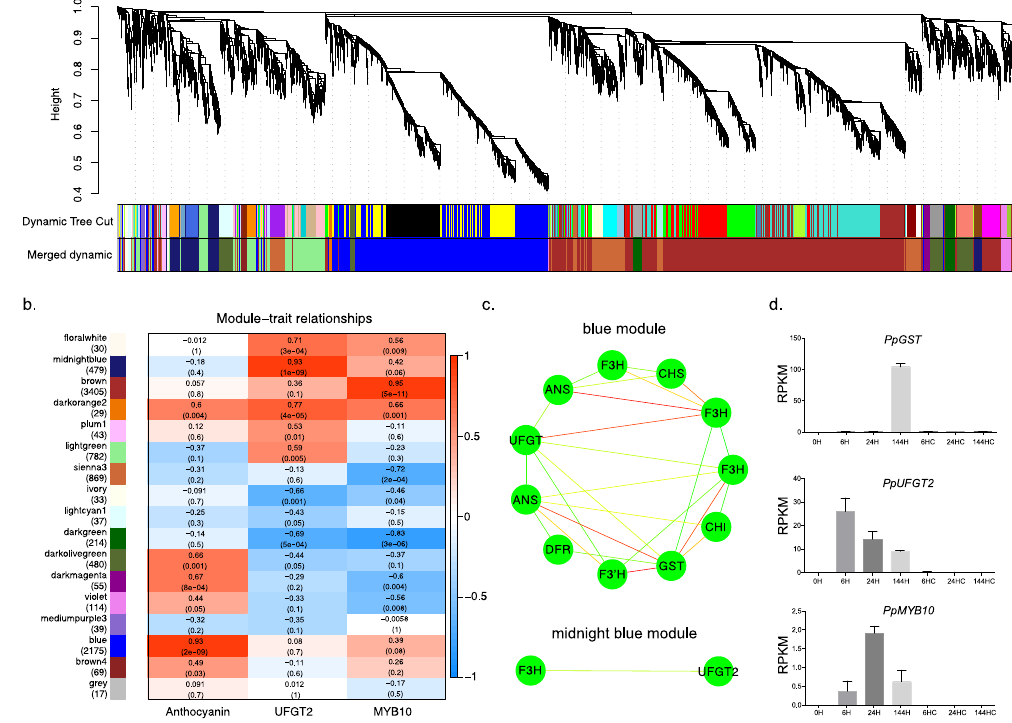
Figure 3. Weighted gene co-expression network analysis (WGCNA) of DEGs identified from ‘Meirensu’ pear peel after bag removal. ( a ) Hierarchical cluster tree showing 17 modules of co-expressed genes. Each of the 8,870 DEGs is represented by a tree leaf and each of the modules by a major tree branch. The lower panel shows modules in designated colours. ( b ) Module–trait correlations and corresponding p -values (in parentheses). The left panel shows the 17 modules and the number of member genes. The colour scale on the right shows module– trait correlations from − 1 (blue) to 1 (red). The left panel “Anthocyanin” represents anthocyanin biosynthesis as a trait. The middle panel “UFGT2” represents the expression changes of PpUFGT2 , which encodes the enzyme that catalyses the last step in anthocyanin biosynthesis, as a trait. The right panel “MYB10” represents the expression changes of PpMYB10 , which is the key transcriptional factor activating anthocyanin biosynthesis, as a trait. ( c ) Cytoscape representation of co-expressed genes with edge weights ≥ 0.40 in module ‘blue’ and ‘midnight blue’. ( d ) RNA-Seq expression patterns of PpGST , PpUFGT2 and PpMYB10